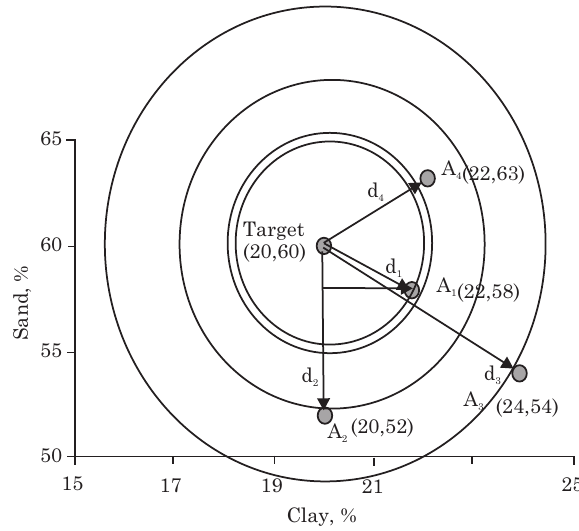
Figure 4. Graphical representation of k-NN for finding the “best” match for a target soil. Source: Jagtap et al.